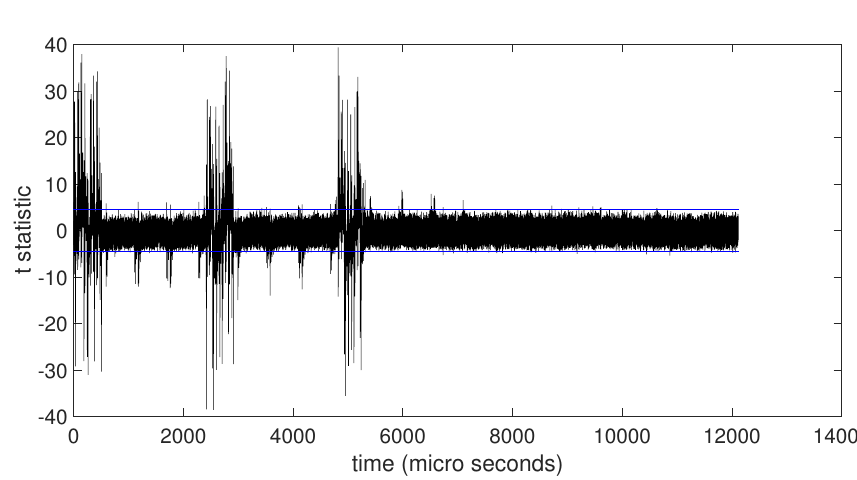
Figure 2: Leakage analysis with disabled masking after 12,000